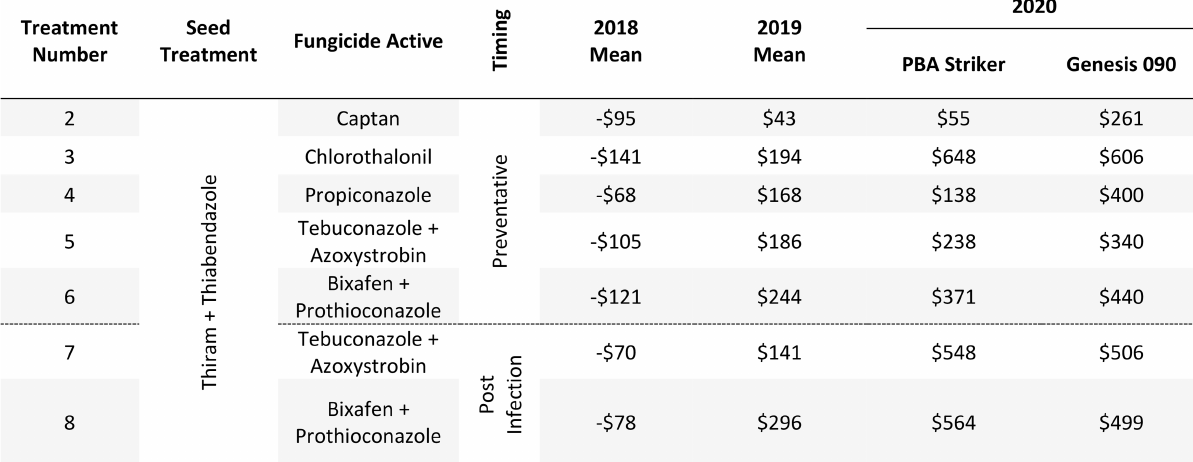
TABLE 12 Gross Margin ($AUD/ha) at Curyo between seven fungicide strategies to control Ascochyta blight and two cultivars with differing resistance, between 2018